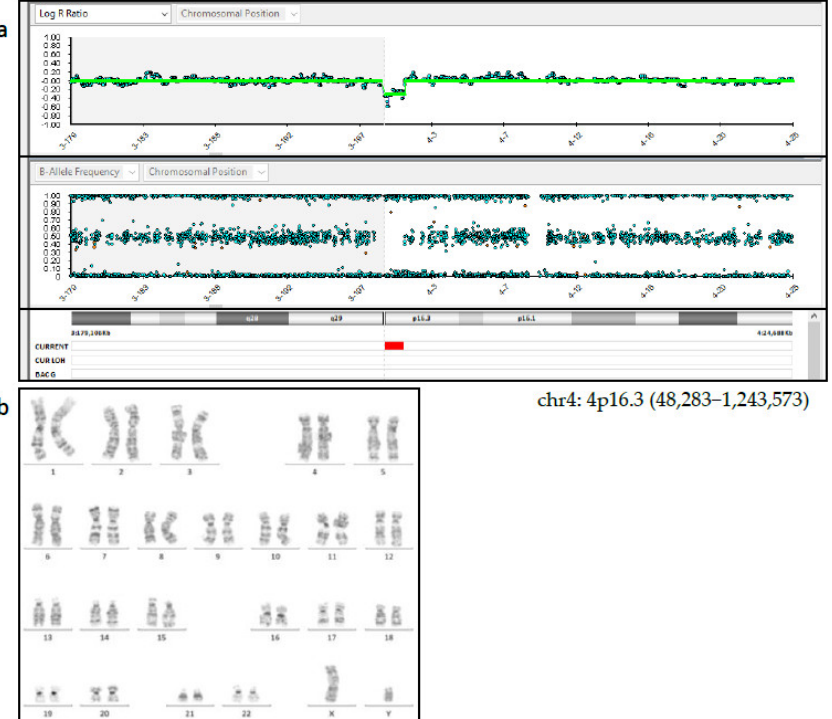
Figure 2. ( a ) SNP-array analysis of amniotic fluid showed a de novo deletion of 1.2 Mb at chromosome 4: 4p16.3 (48,283–1,243,573). ( b ) GTG banding on cultured cells from the amniotic fluid showed a 46,XY karyotype.